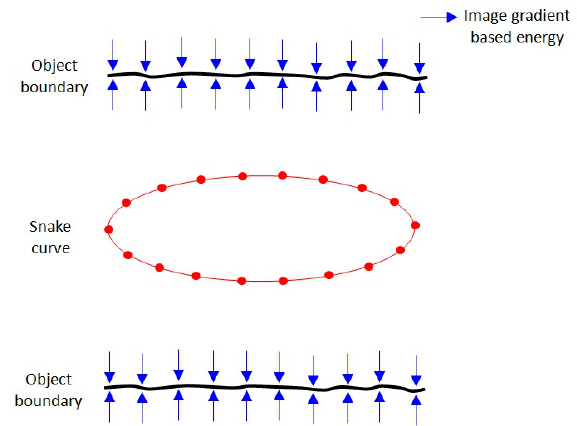
Figure 2. Snake curve initialised on the gradient image of object